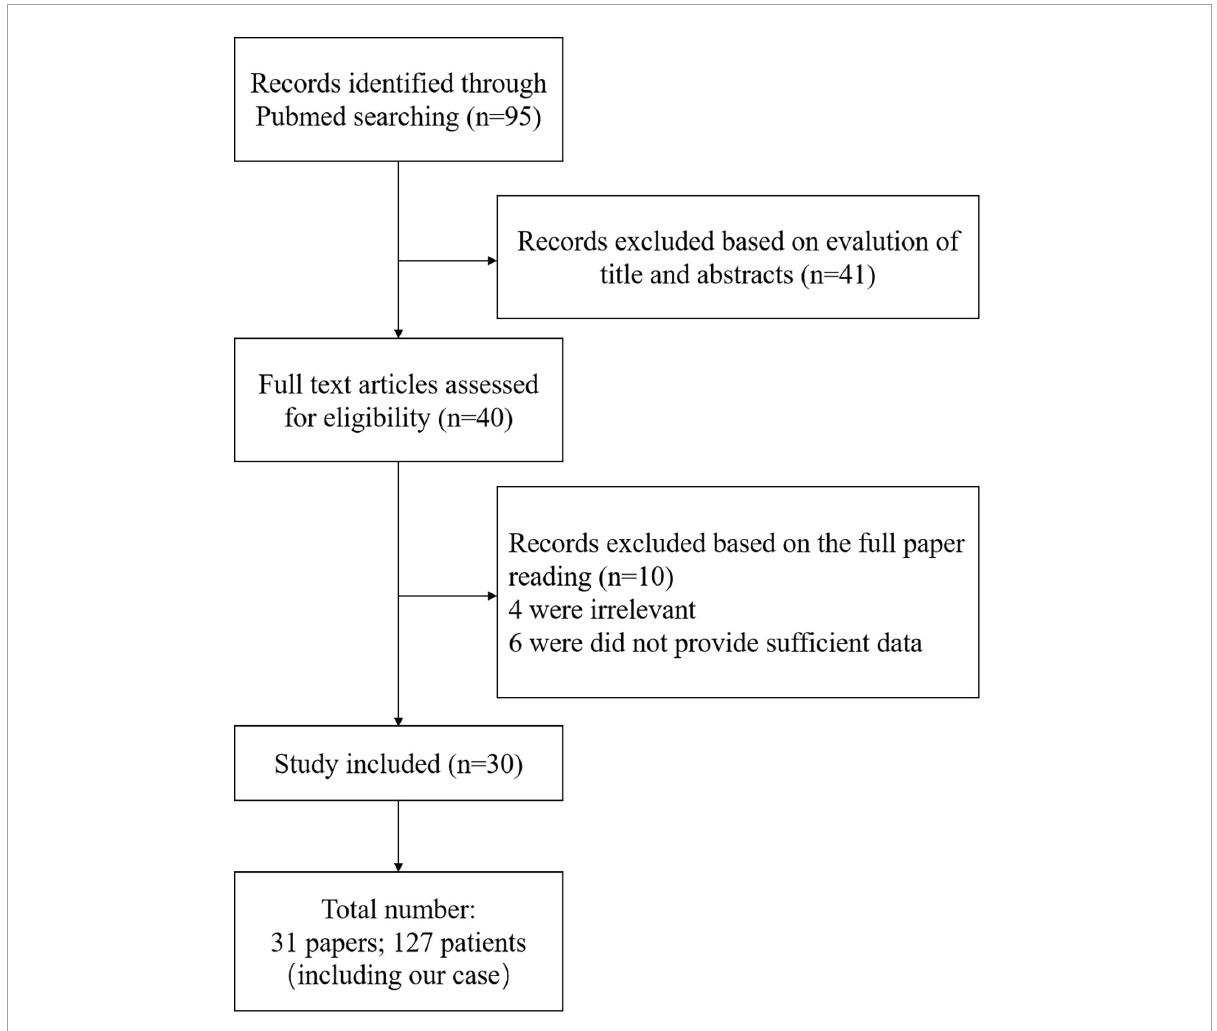
FIGURE3 Screening